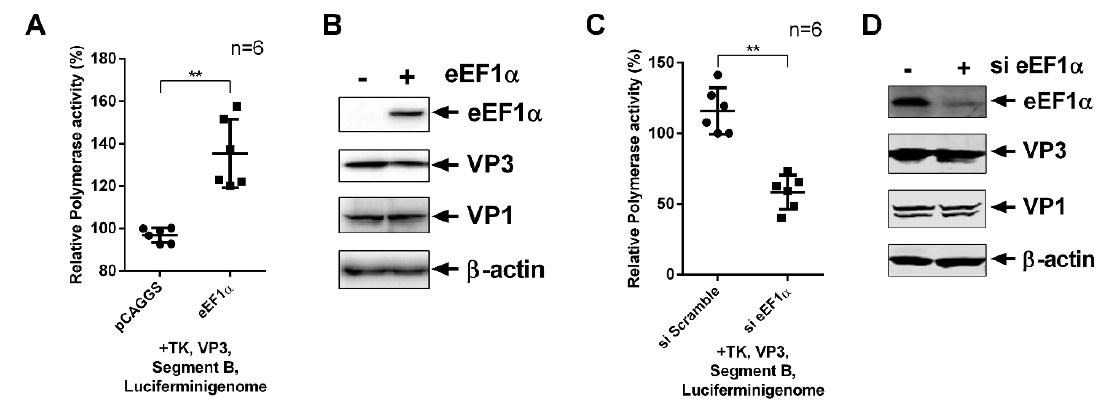
Figure 6. cheEF1 α enhances the activity of vvIBDV polymerase. ( A , B ) Effects of cheEF1 α over-expression on virus polymerase activity. The polymerase activity assays were performed in 293T cells expressing vvIBDV segment B-driven luciferase minigenome system, accompanied with VP3, segment B, TK, and cheEF1 α or empty vector pCAGGS. VP1, VP3, and cheEF1 α protein expressions were analyzed by Western blotting with β -actin as a loading control. ( C , D ) E ff ects of eEF1 α knockdown on virus polymerase activity. 293T cells were first transfected with commercial competent eEF1 α siRNAs or scrambled control siRNAs. Polymerase activity assays were performed at 36 h post-second transfection with viral polymerase system as described in (A). VP1, VP3, and eEF1 α protein expressions were analyzed by Western blotting with β -actin as a loading control. Error bars, mean ± SD were calculated on the basis of three independent experiments. Statistical analysis was performed with the t -test with significance shown by two asterisks as p <0.01.